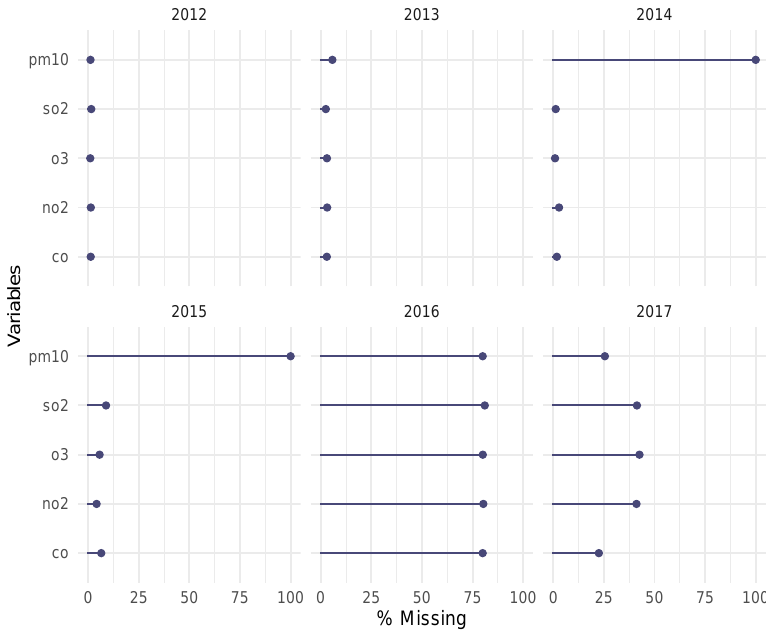
Figure A2. Missing values for air quality pollutants from 2012 to 2017 per